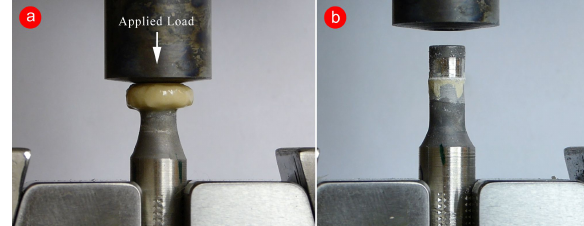
Figure 4: Shear bond strength test architecture (a) before and (b) after the ceramic detachment